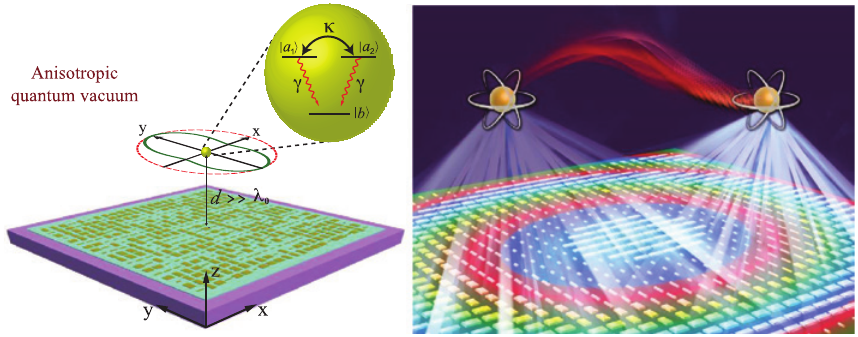
Figure 8: Metasurface-enabled quantum interference and quantum entanglement. (Left) Multilevel quantum emitter located at a macroscopic distance from the metasurface exhibits coupling between mutually orthogonal atomic transitions. Reprinted from Ref. [23]. Copyright © 2015 by the American Physical Society. (Right) Quantum correlations between two qubits located over macroscopic distances. Using an optimally designed metasurface, emission from one qubit can be efficiently redirected toward the target qubit. Reprinted from Ref. [24]. Copyright © 2017 by the American Chemical